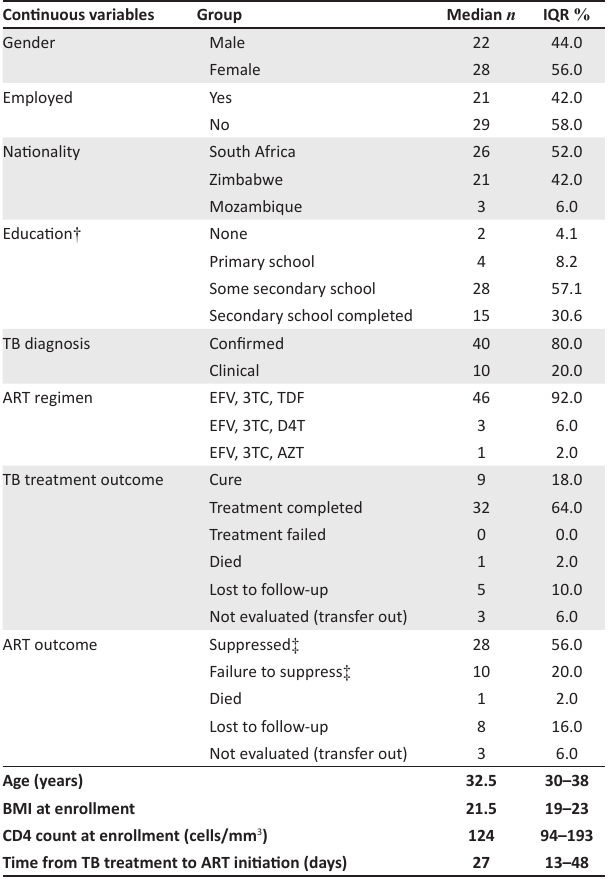
TABLE 1: Characteristics of 50 individuals included in the analysis of the impact of initiation of antiretroviral treatment on adherence to tuberculosis treatment. Continuous